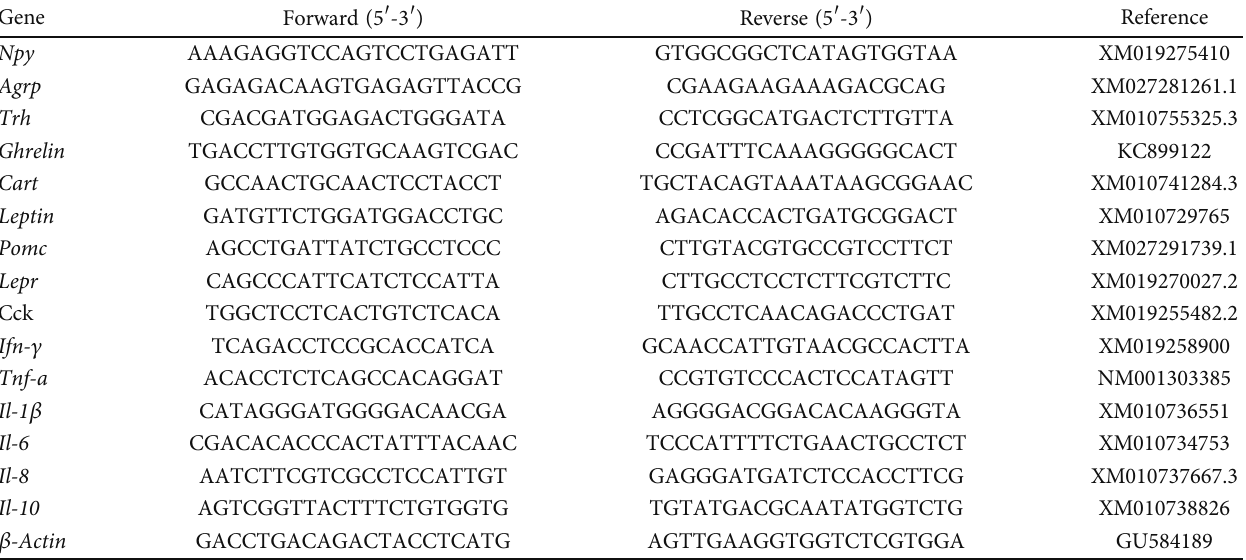
Table 2: Primer sequences of RT-qPCR used in this study.